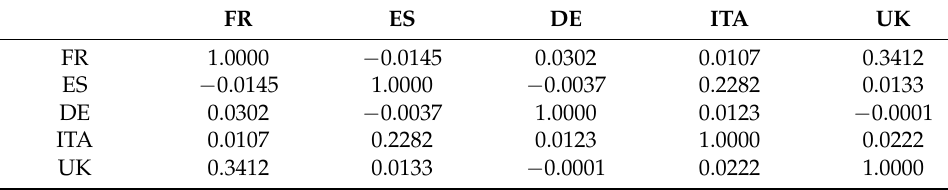
Table 2. Correlation matrix of electricity return.